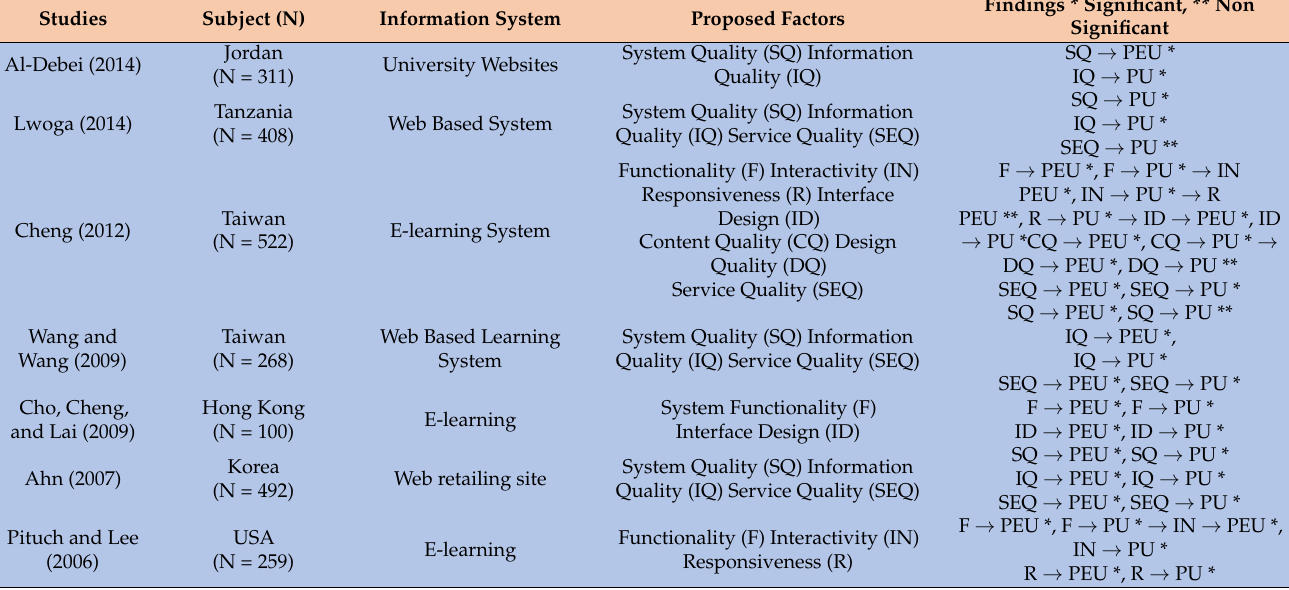
Table 2. Previous studies of the relationship between quality factors and perceived ease of use (PEU) and perceived usefulness